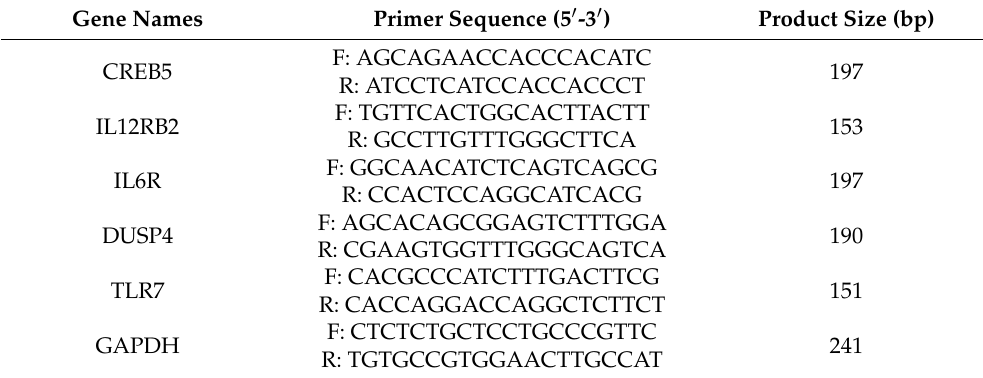
Table 3. Primers used for qPCR